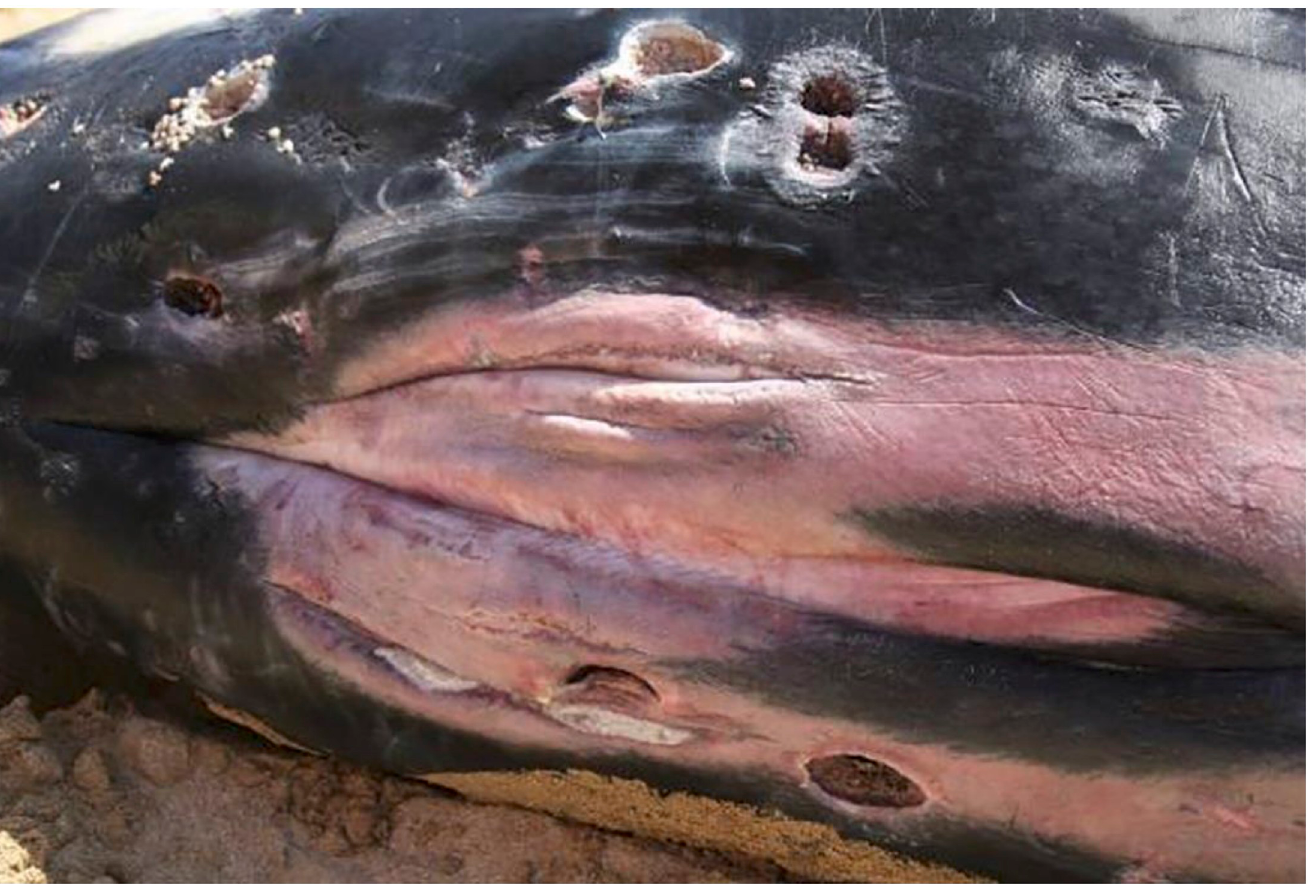
Fig 5. Irregularly round cutaneous defects often populated by cyamid crustaceans seen on 20081021. These 3–5 cm diameter lesions are believed to be cookiecutter shark ( Isistius sp.) bite wounds.